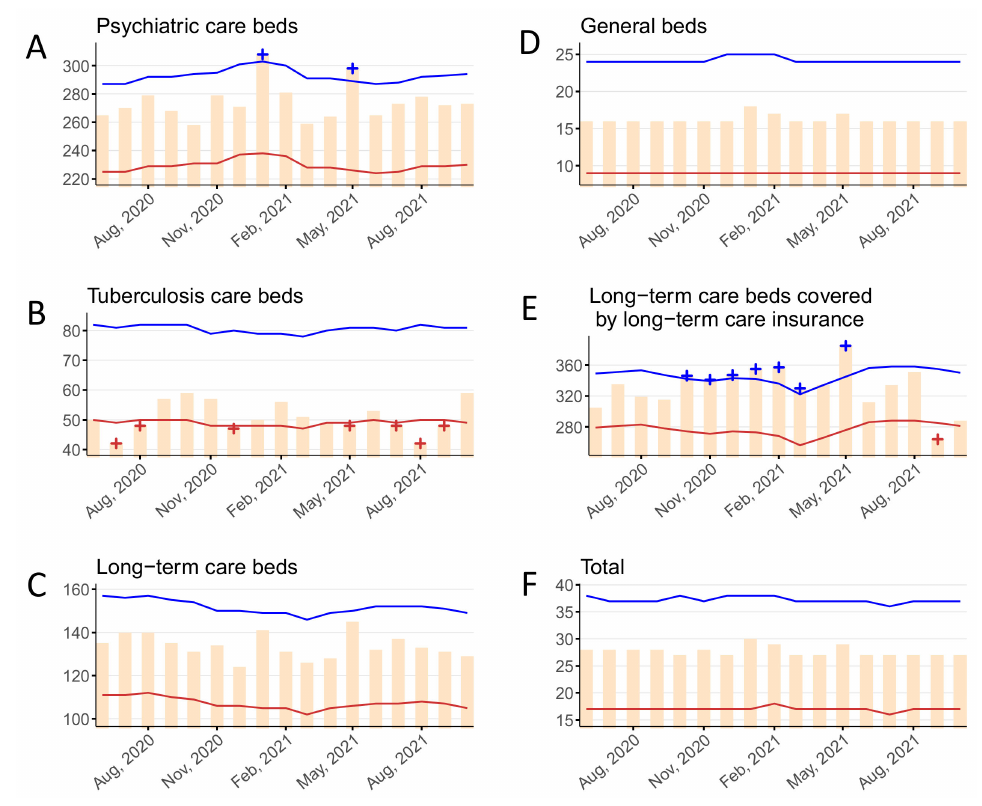
Figure 3. The monthly average length of hospital stay per patient stratified by bed type, June 2020– October 2021 in ( A ) psychiatric beds, ( B ) tuberculosis beds, ( C ) long-term care beds, ( D ) general beds, ( E ) long-term care beds covered by long-term care insurance, and ( F ) in total. Yellow bars indicate the observed number of days. Blue and red lines show the upper and lower limits, respectively, of the 95% prediction interval. Blue and red + symbols indicate statistically significant monthly excesses and deficits, respectively. Gray shading corresponds to the state of emergency declarations in